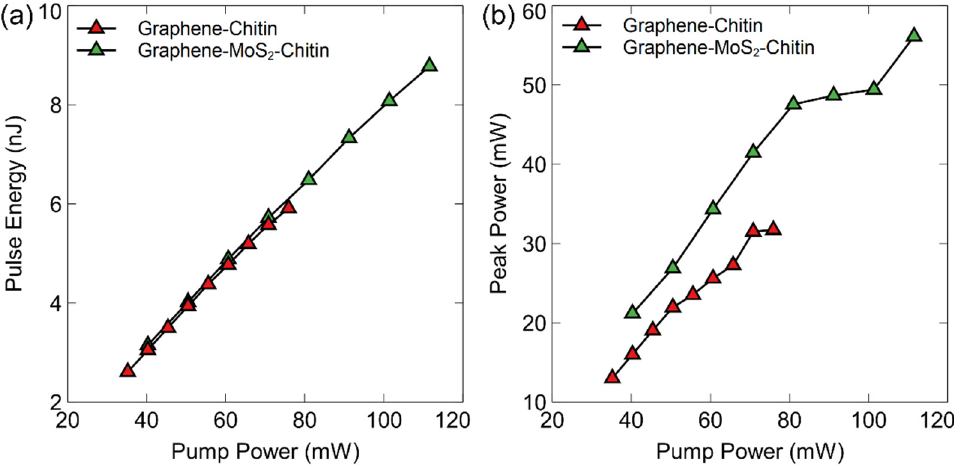
Figure 13. Variation of ( a ) pulse energy and ( b ) peak power against pump power of graphene-chitin and graphene-MoS 2 -chitin.